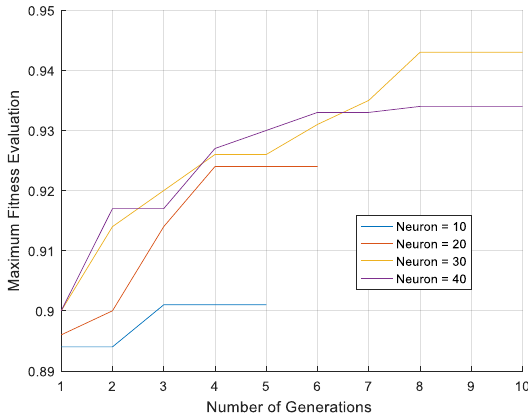
Figure 8. Simulation results of GA-NN with different neurons.